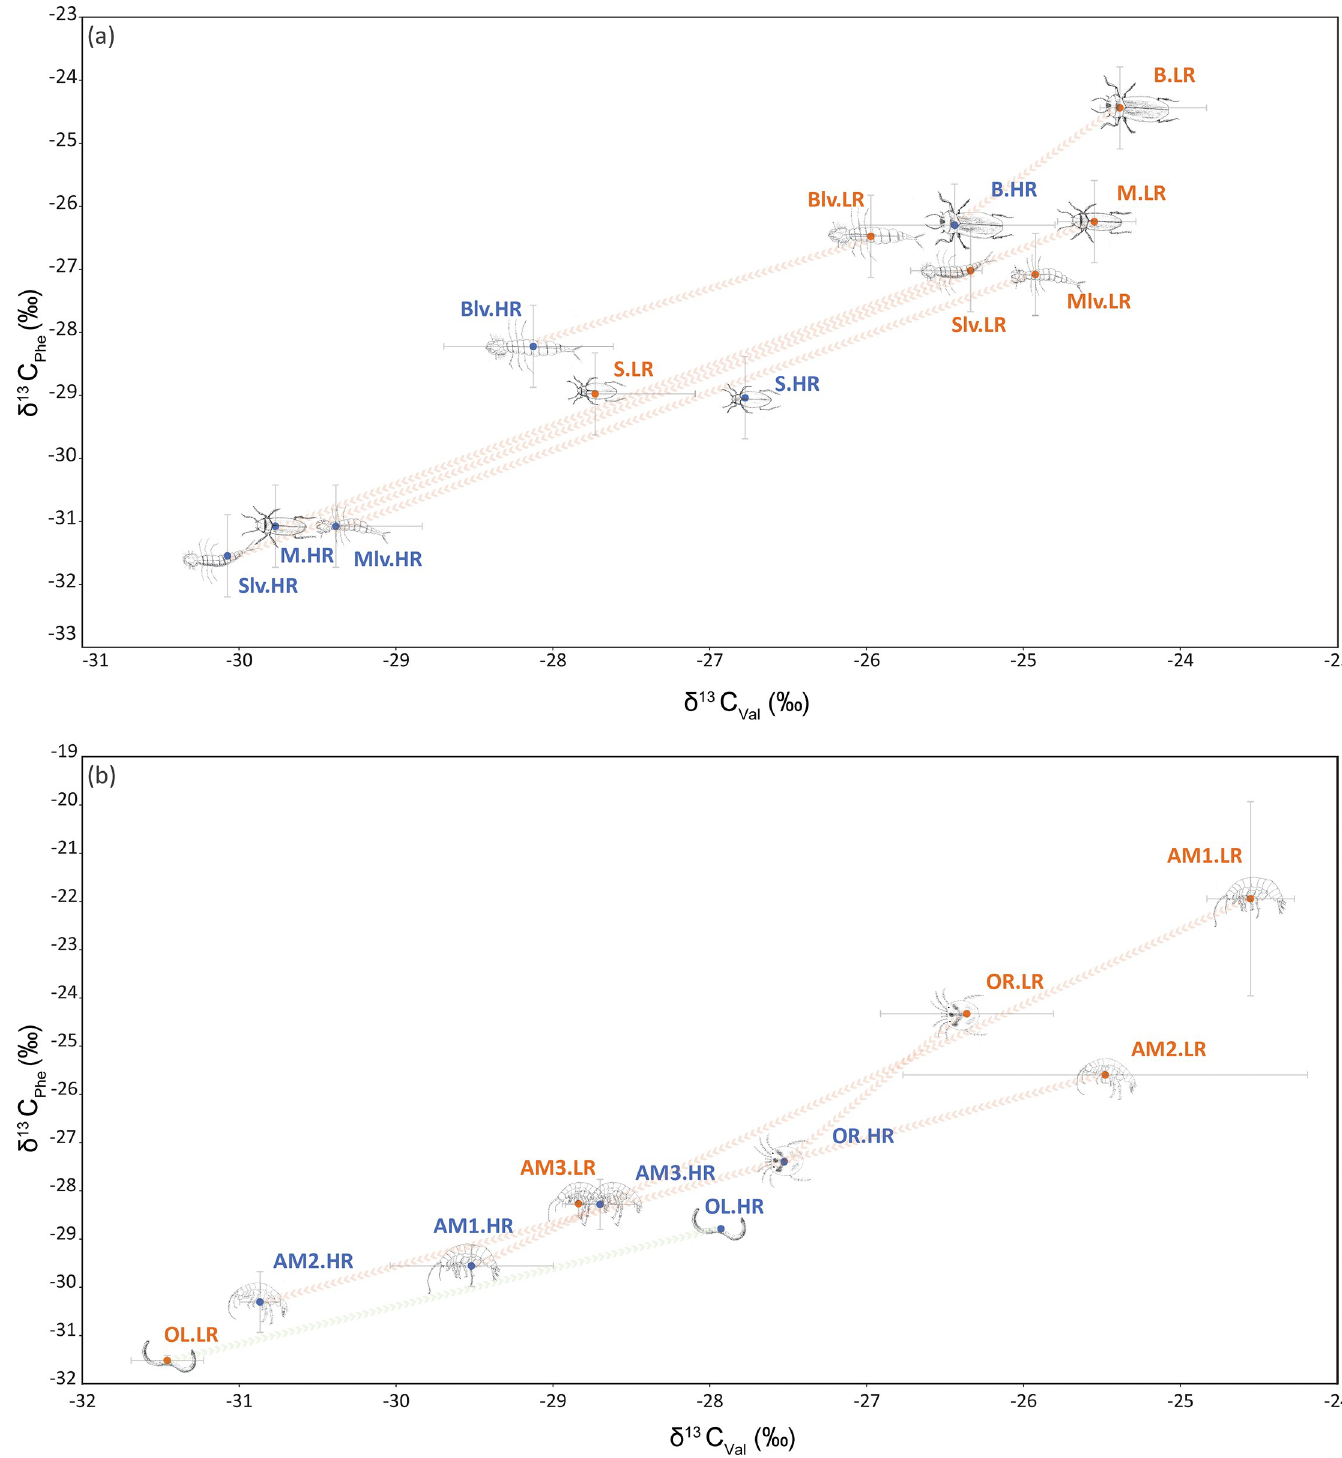
Fig 3. Biplot of δ 13 C Phe values vs. δ 13 C Val values for a) beetles (B, M, S, Blv, Mlv and Slv) and b) amphipods (AM1, AM2 and AM3), water mites (OR) and aquatic worms (OL). Red arrows indicate significant decreasing trends between LR and HR, while green arrows indicate increasing trends within rainfall periods. Refer to Table 1 for taxa